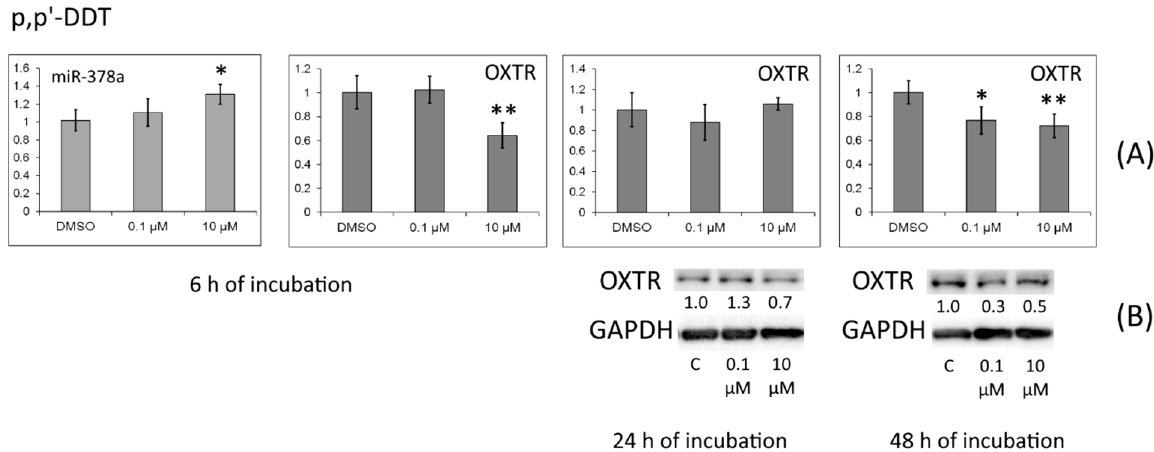
Figure 3. ( A ) Relative levels of OXTR mRNA and of the miRNA targeting it (miR-378a) in MCF-7 cells exposed to p,p ′ -DDT. The Y-axis represents the ratio of the mRNA or miRNA amount in the cells treated with a DDT isomer to the mRNA or miRNA amount in the cells treated with DMSO. Each value is the mean of three independent experiments. * Significant differences from the control ( p < 0.05); ** p < 0.01. ( B ) Western blot analysis of OXTR in cells incubated with p,p ′ -DDT. The numbers under OXTR bands denote fold change in the protein level as compared to the first band (control); each data point was normalized to the corresponding GAPDH band. We present data from one of three independent experiments (which yielded similar results).